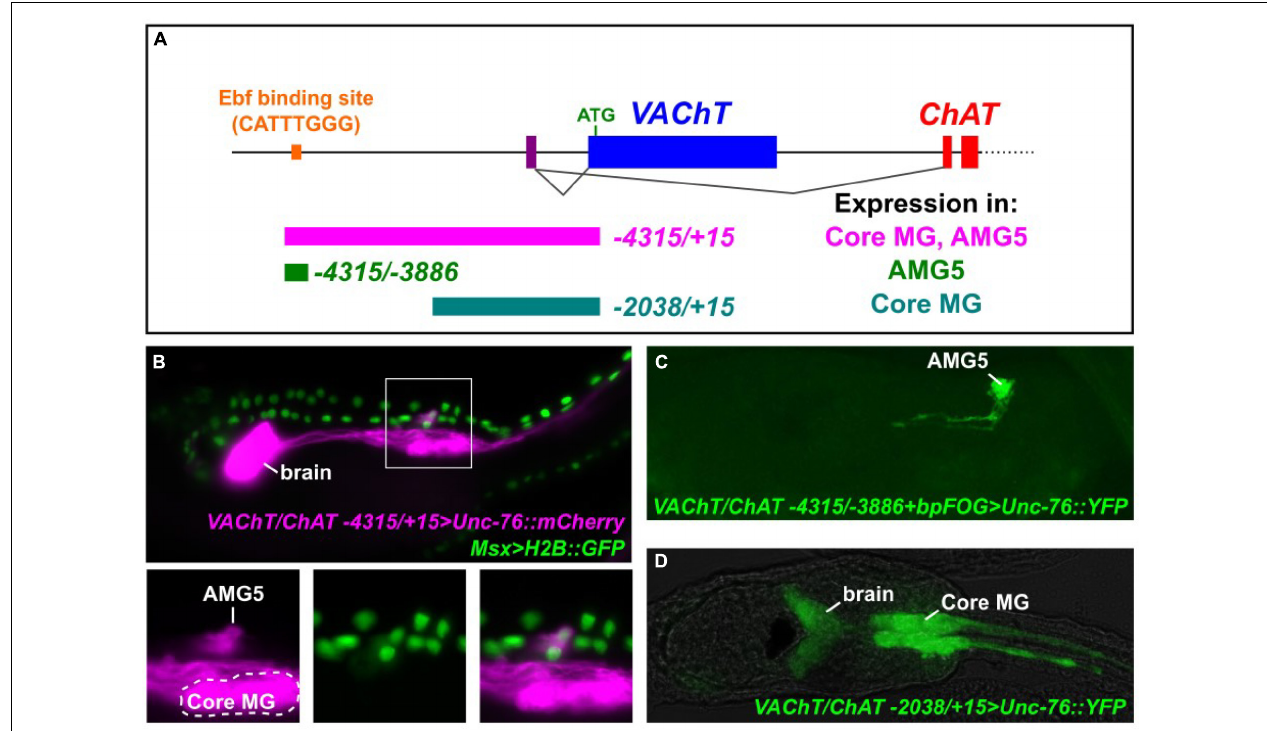
FIGURE 1 | Expression of VAChT/ChAT cholinergic locus in the AMG5 neuron. (A) Cartoon schematic of the VAChT/ChAT locus encoding VAChT and ChAT from two mutually exclusive, alternatively spliced transcript variants sharing the same non-coding exon 1 (purple bar). Dotted line indicates additional exons encoding ChAT not shown. Colored bars underneath locus indicate cis -regulatory sequences tested, numbers reflect distance from the start codon (+ 1) of VAChT . Expression in “core” motor ganglion (MG) and Ascending Motor Ganglion neuron 5 (AMG5) was assessed qualitatively. An Ebf binding site previously reported (Kratsios et al., 2012) is situated -4111 bp upstream of VAChT. (B) Co-electroporation of VAChT/ChAT - 4315/ + 15 > Unc-76:mCherry and Msx > H2B:GFP revealed co-expression in AMG5 at 19 h post-fertilization (hpf) at 20 ◦ C, a cholinergic interneuron of the dorsal MG, derived from the dorsal cells of the neural tube. (C) A minimal fragment surrounding the Ebf binding site is sufficient to drive AMG5-specific reporter expression at 18 hpf, 20 ◦ C. Image is a confocal Z stack projection. (D) A smaller proximal fragment from VAChT/ChAT ( - 2083/ + 15) lacking the Ebf binding site is sufficient to drive expression in other cholinergic neurons including those of the core MG, but not in AMG5, at 19 hpf, 18 ◦